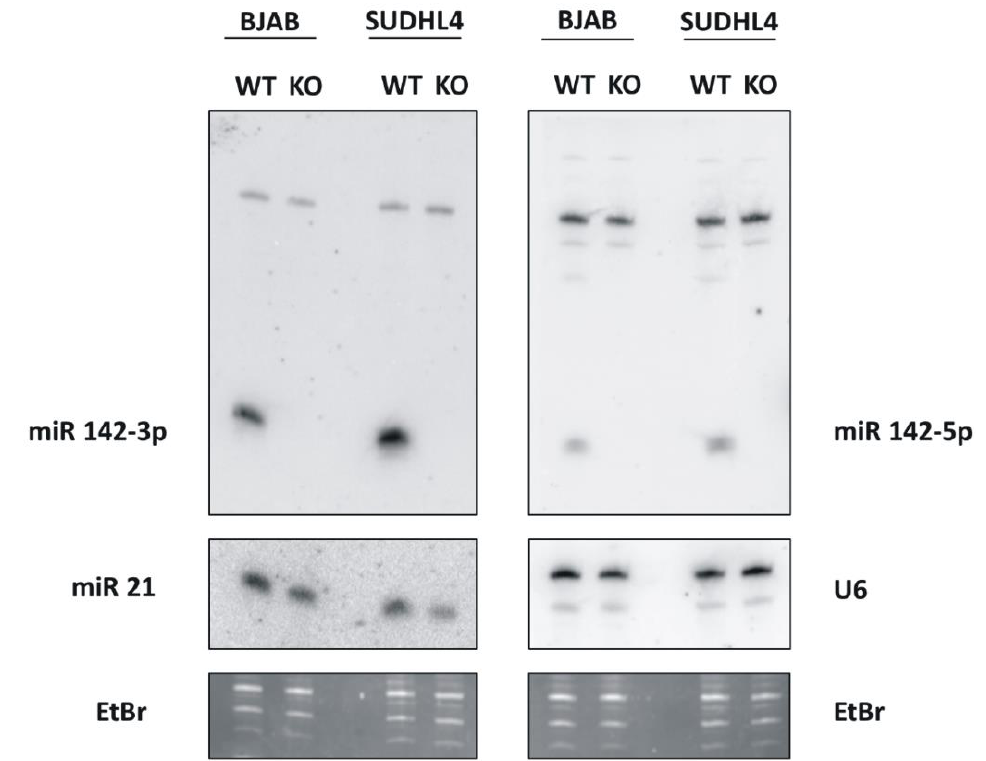
Figure 1. Analysis of miRNA expression in the knockout cells by Northern blotting. Total RNA (10 µ g/lane) from the BJAB-wild-type and SUDHL4-wild-type (“WT”) cells and the corresponding miR-142 knockout (“KO”) cells was separated on a 12% polyacrylamide gel, transferred to a nitro- cellulose membrane and hybridized with 32 P-labelled probe for miR-142-3p (left upper panel) or miR-142-5p (right upper panel). Bound probe was detected using a PhosphoImager. The bound probes were removed and the membranes were re-hybridized either with a probe to detect miR-21 (left side of middle panel) or U6 RNA (right side of middle panel) as indicated. The bottom panel shows the Ethidiumbromide (“Etbr”) -stained gels as loading control.